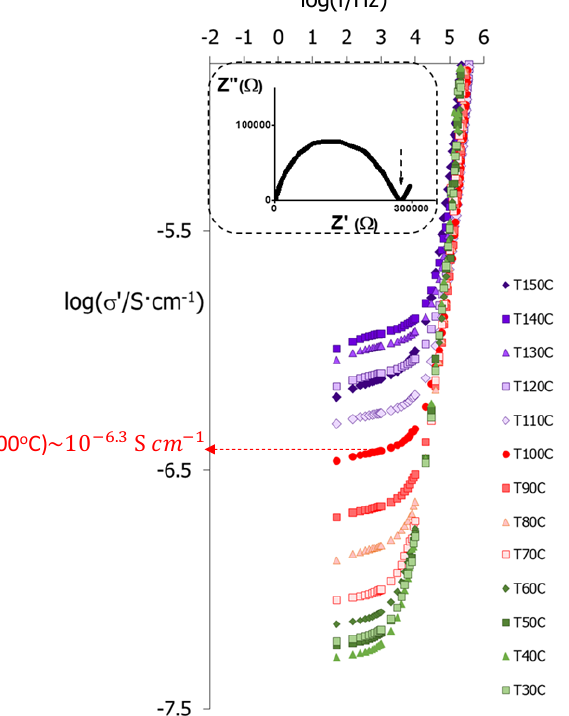
Figure 8. Double logarithmic plots of the real component, σ’, of the complex conductivity of PA-b-PS-b-PM, as a function of the frequency, measured in isothermal steps (°C) on cooling from the isotropic melt, and estimation of DC conductivity, σ dc at T = 100 °C. Dotted arrow in the inset shows the spike in the impedance Nyquist plot, which is indicative of DC conductivity.